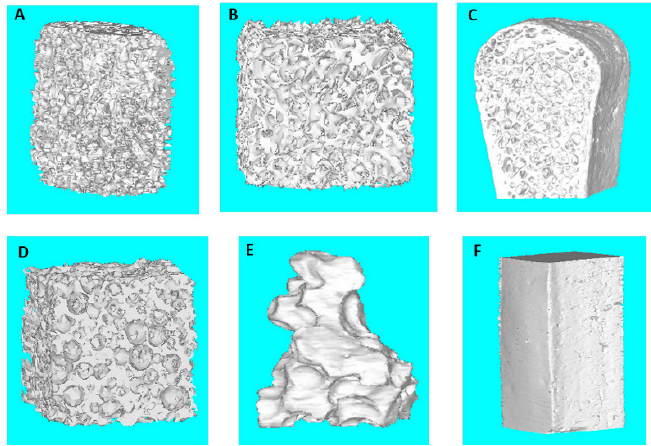
Figure 3. Complete 3D models reconstructed of the biomaterials analyzed in the preclinical phase: ( A ) BioOSS ® , 1a; ( B ) Biogen ® , 1b; ( C ) ICB; ( D ) ENGIpore ® , 2b; ( E ) Bioset, 3a and ( F ) SINTbone, 4a. 3.2 Clinical phase: morphological, quantitative and histological results on extracted implants.